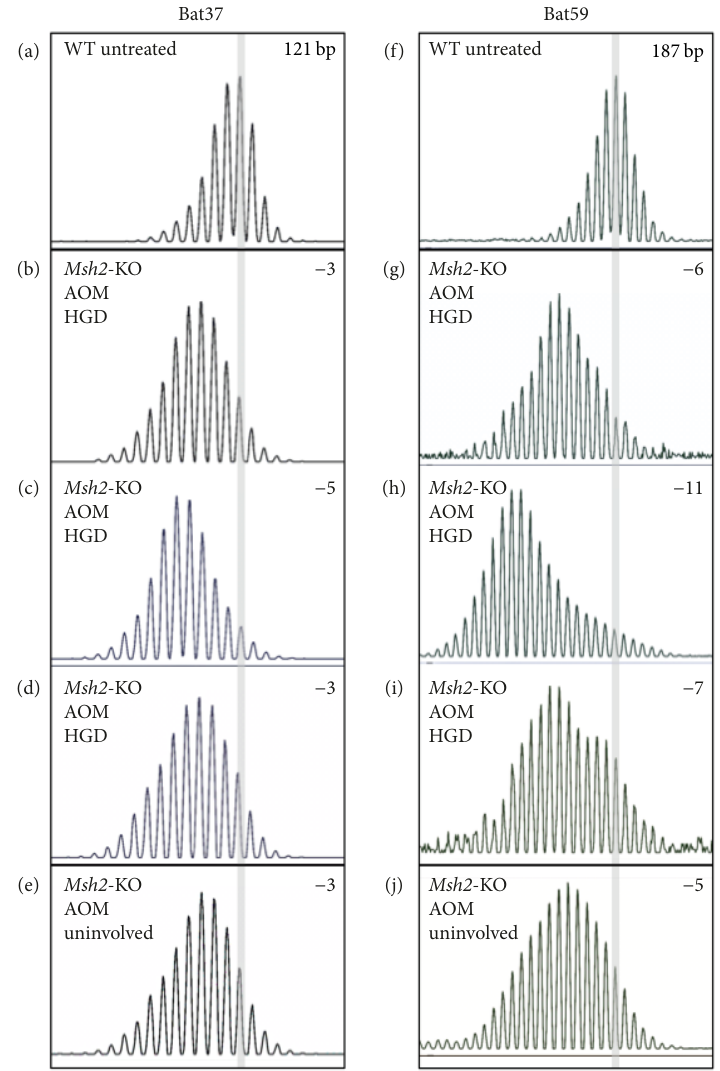
Figure 4: AOM-treated Msh2- KO mice display further contraction of the mononucleotide repeats in the distal colon. (a, f) Bat37 and Bat59 in the colon of a WT mouse; (b–d); (g–i) AOM-induced tumors from a Msh2 -KO mouse; (e, j) uninvolved colon tissue from an AOM-treated Msh2 -KO mouse. The position of the highest peak in the WT mouse is highlighted with the grey bar; 121 and 187 bp refer to the size of the PCR fragment in the WT and the number in the top right corner indicates the number of nucleotides by which the repeat is shortened in the Msh2 -KO